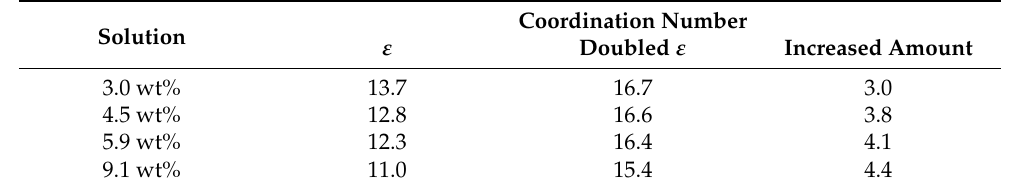
Figure 6. Illustration of the permeation when the ε value of the S Ar solute is as denoted in Table 1 in ( a ) and doubled in ( b ). The blue and green spheres represent the solvent and the solute, respec- tively. Table 2. Calculated coordination numbers of the solvent atom surrounding solute (Na). The values for the ε were calculated from the RDFs, as shown in Figure 5a. The values for the doubled ε were calculated from the RDFs, as shown in Figure 5b.